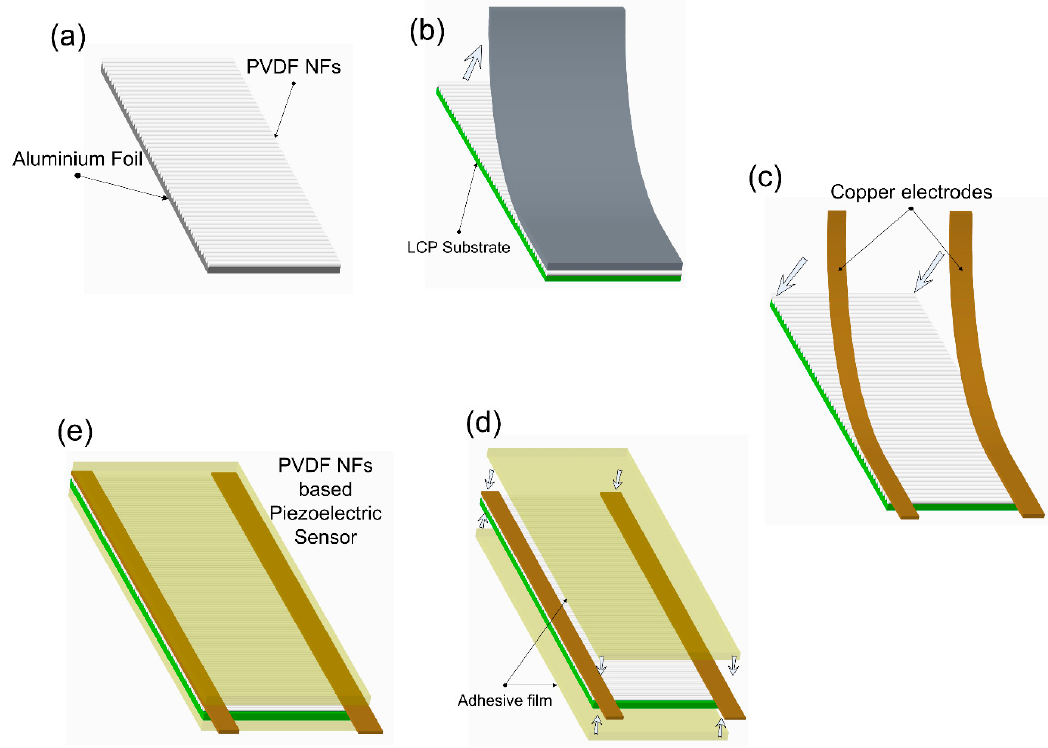
Figure 5. Fabrication process of the high sensitive stretchable strain sensor based on PVDF electrospun nanofiber on a flexible liquid crystal polymer (LCP) substrate. a ) PVDF nano fibers were collected on an Aluminum foil substrate through far field electrospinning process b ) Fibers were carefully